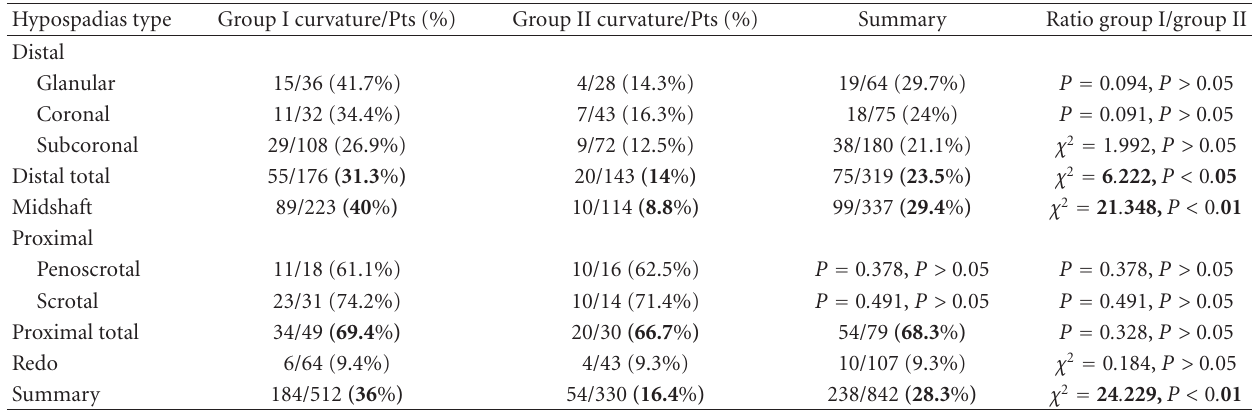
Table 1: Type of hypospadias and incidence of associated curvature.